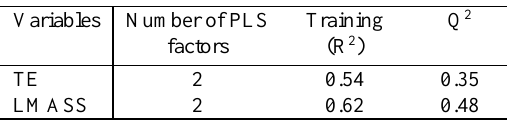
Table 3. Performance of PLS models in predicting